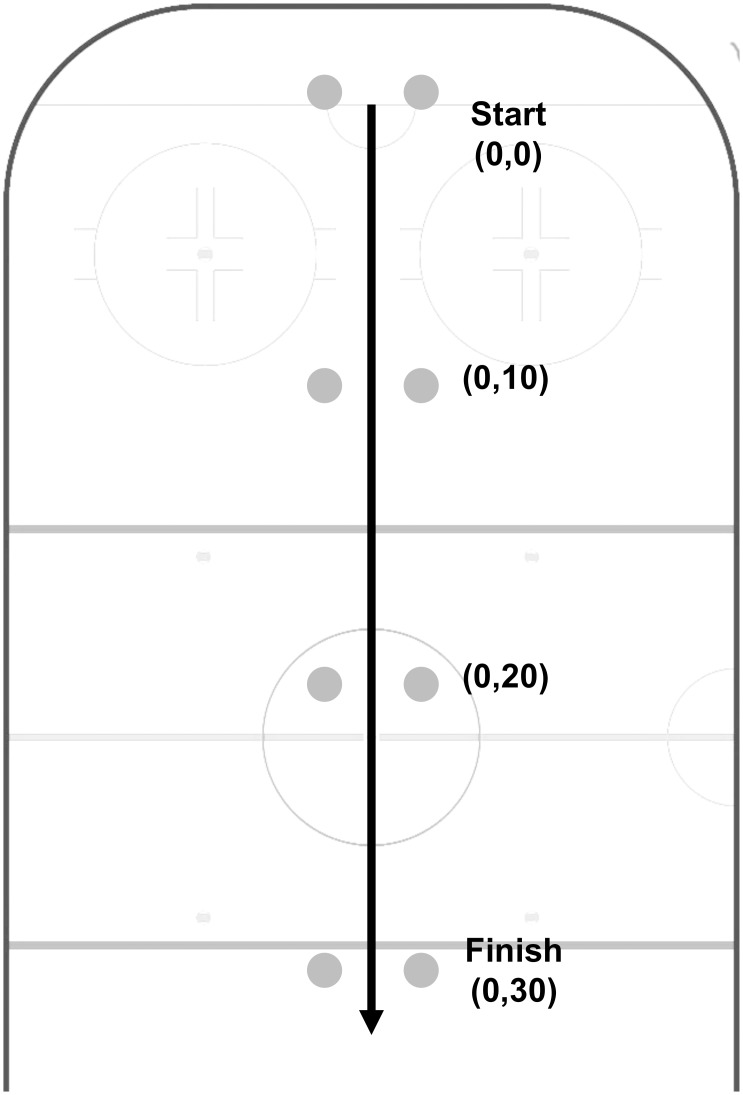
Diagram of the test setup for the 30 m maximum effort forward skating drill.Grey circles represent the position of timing light gates. Co-ordinates are medio-lateral and anterior displacements from the start position (0, 0). The direction of motion is shown by the black arrow.